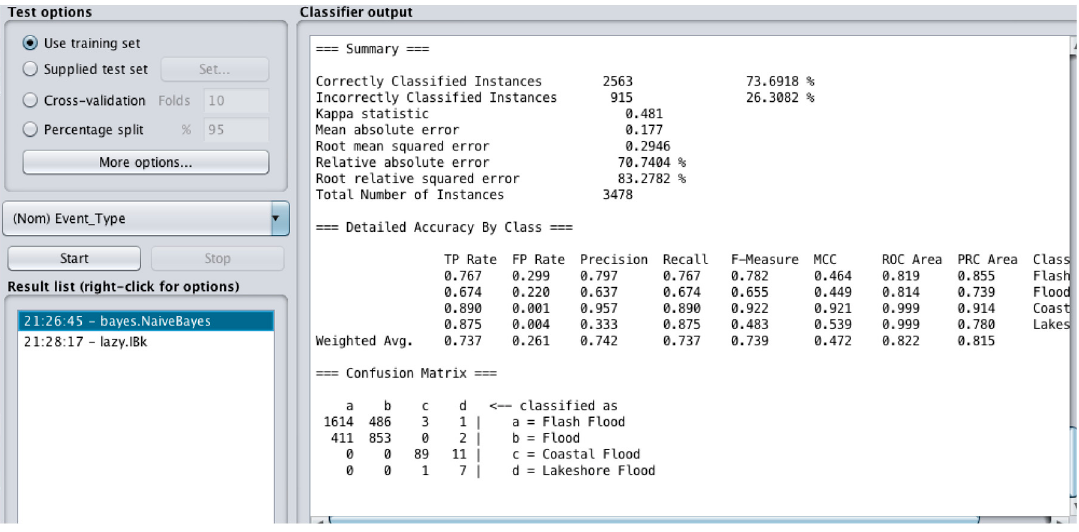
Figure 11. Evaluation Results for Naïve Bayes model in Weka.